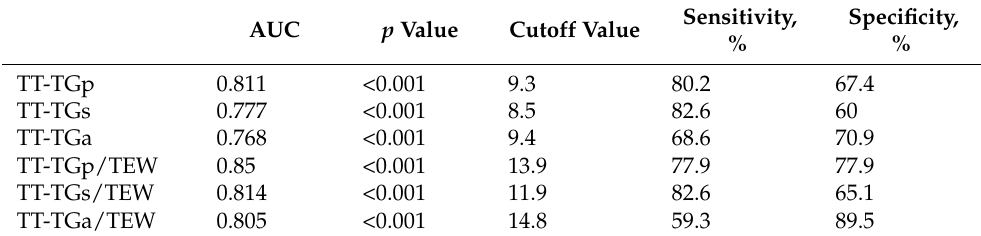
Table 4. Sensitivity and Specificity of the Cutoff Values.